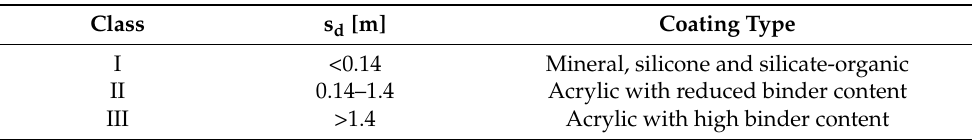
Table 3. Classes of vapor permeability of plasters according to PN-EN 1062-1 (own table based on [58]).